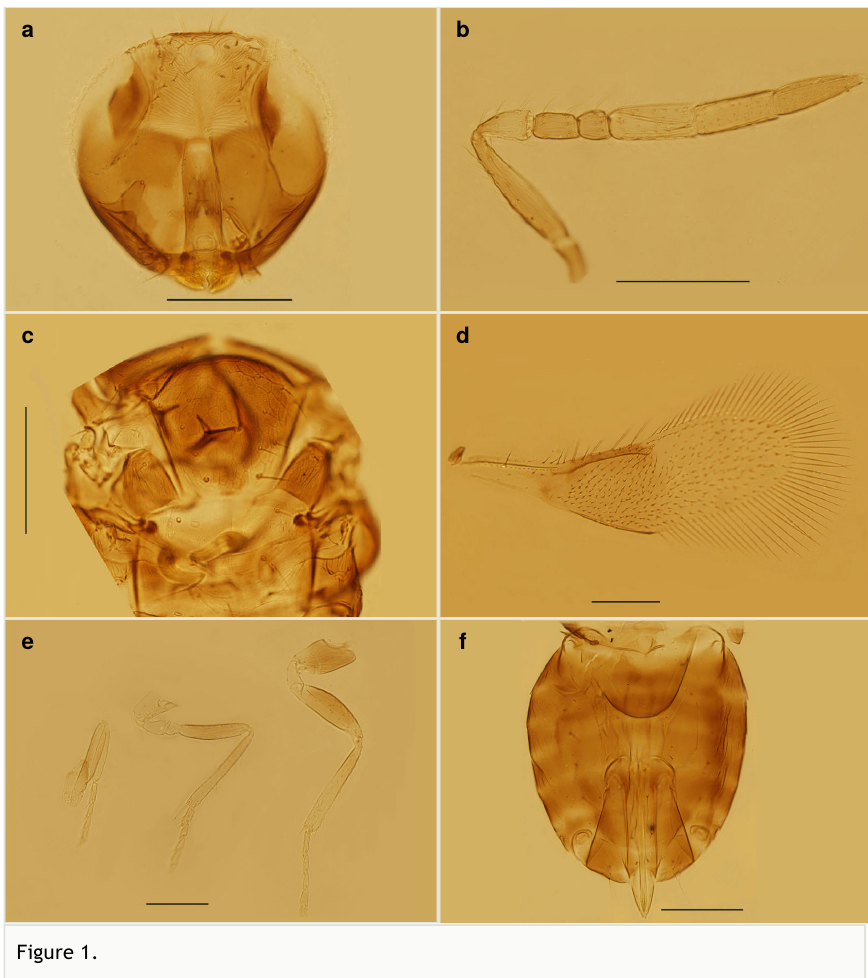
Pteroptrix pedicellata sp. n.,